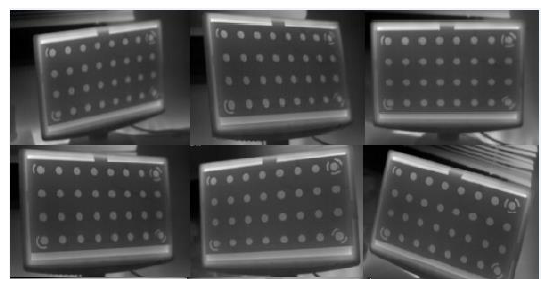
Figure 4. The imaging network for calibrating the thermal camera